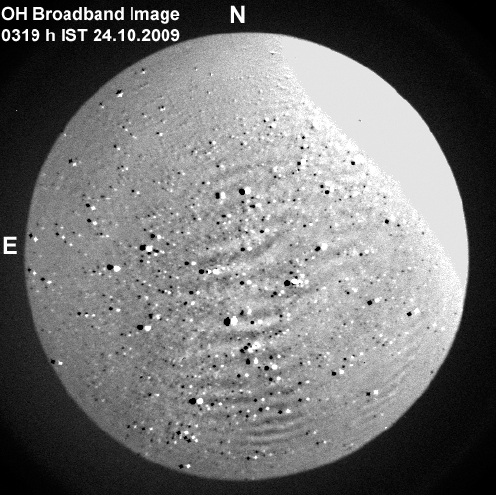
Figure 11. Sample image of OH broadband emission over Alla- habad on 23–24 October 2009 with northward-propagating small- scale